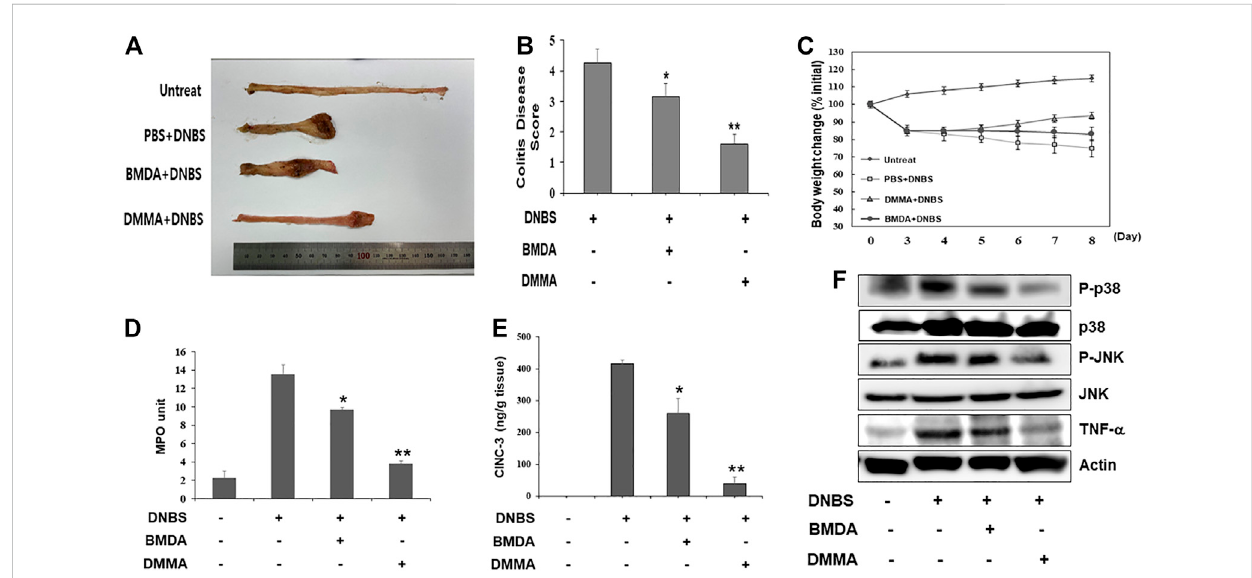
Rectal treatment with BMDA or DMMA relieves DNBS-induced colitis by decreasing in fl ammatory mediators (A) Distal colons of DNBS-induced colitis from rats ( n = 5rats per group) treated with BMDA (100 μ g, 0.5 mL − 1 PBS per rat), DMMA (100 μ g.0.5 mL − 1 PBS per rat), or PBS (0.5 mL) as a control for 5 days were photographed. Representative images are shown. (B) DNBS-induced colitis in rats treated with BMDA, DMMA, or PBS was evaluated by colon damage score described in Materials and Methods. (** p < 0.01, PBS + DNBS vs . DMMA + DNBS. * p < 0.05, PBS + DNBS vs . BMDA + DNBS) (C) Body weight of rats treated with DNBS for three consecutive days was measured from starting day for rectal administration of BMDA, DMMA or PBS, and themeasurementwasthereafterkeptfor5 days. (D) Myeloperoxidase(MPO)activityfromin fl ameddistalcolonsofratstreatedwithBMDA,DMMA,orPBS was measured. (** p < 0.01, PBS + DNBS vs . DMMA + DNBS. * p < 0.05, PBS + DNBS vs . BMDA + DNBS) (E) Concentration of CINC-3 from in fl amed distal colons ofratstreatedwithBMDA,DMMA, orPBSweremeasuredbyELISA.(**; p < 0.01,PBS+DNBSvs . DMMA+DNBS.* p < 0.05, PBS+DNBSvs . BMDA + DNBS) (F) The distal colons of DNBS-induced colitis from the rats treated with BMDA, DMMA, or PBS were minced and prepared for immunoblotting. Phosphorylation levels of JNK and p38 MAPK, and expression levels of TNF- α in the colons were examined with their speci fi c